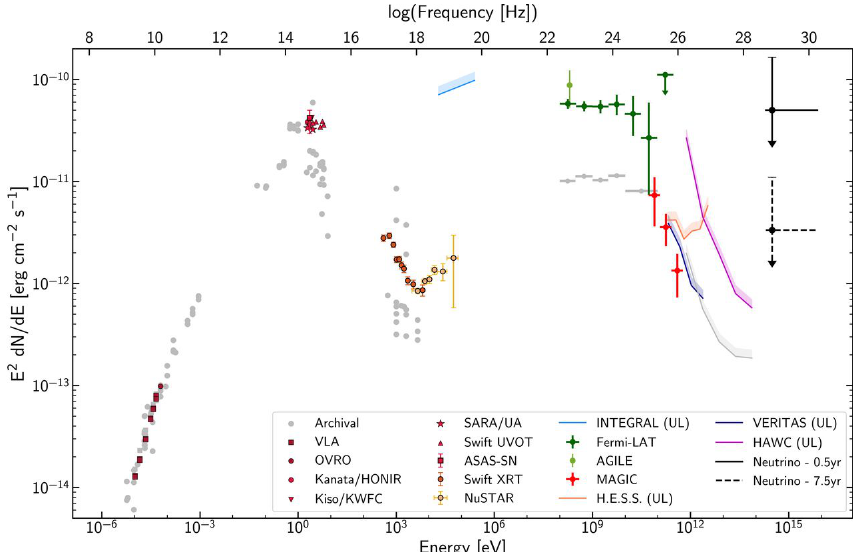
Figure 6. Multi-wavelength spectral energy distributions (SED) of TXS 0506+056, including neutrino flux upper limits corresponding to the IceCube-170922A event, assuming one event in 0.5 years (solid black) and one event in 7 years (dashed black). From [67]. Reproduced with permission by the American Association for the Advancement of Science (AAAS).